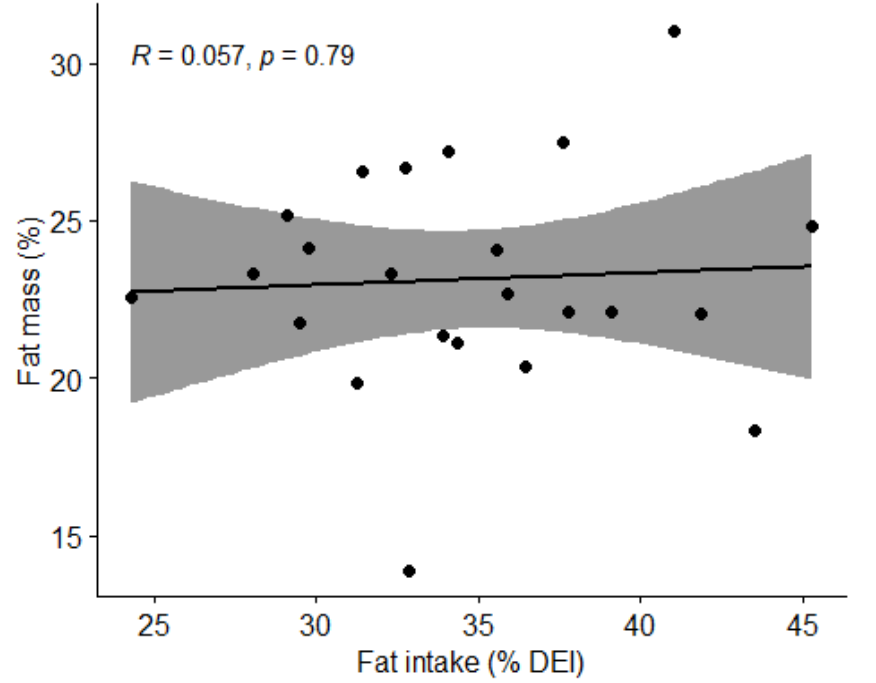
Figure 12. Correlation between fat percentage and body fat percentage in football players. Dots represent individual participants ( n = 23). Grey shaded area indicates 95% CI.